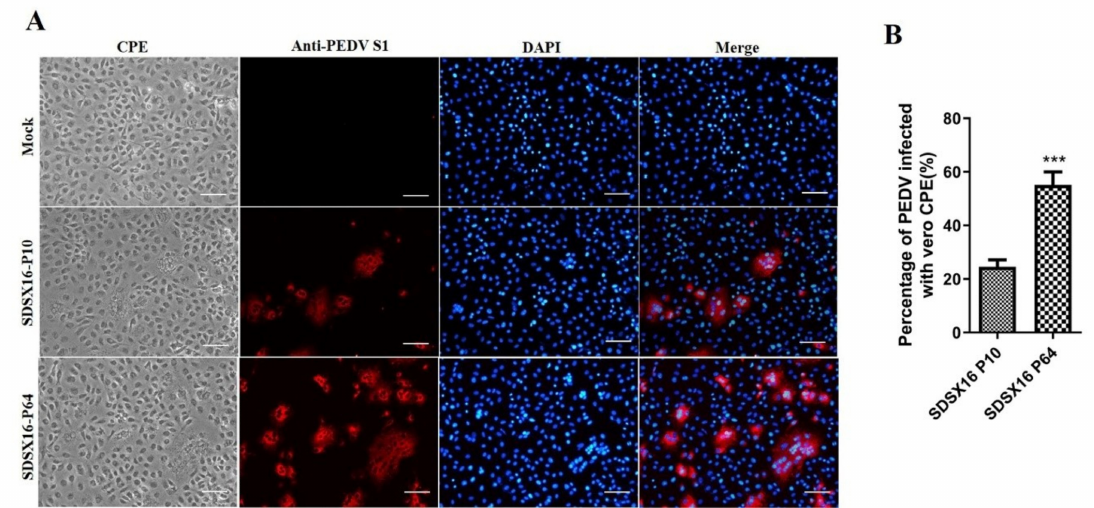
Figure 1. Cytopathology and immunofluorescence assay (IFA) of PEDV isolate SDSX16 in Vero cells. ( A ) Vero cells were infected with PEDV SDSX16-P10 and SDSX16-P64 isolates. PEDV-specific CPEs were monitored daily and were photographed at 48 h post-infection (hpi) using an inverted microscope (first column). For immunostaining, infected cells were fixed at 48 hpi and incubated with MAb against the S protein, followed by FITC conjugated donkey anti-mouse IgG antibody (second column). The nuclei were counterstained with DAPI (third column) and examined using a fluorescence microscope. Scale bar represents 20 µ m. ( B ) Statistical results of the percentage of total cell number of cells producing CPE infected by PEDV in the visual field. Data are shown as mean ± SEM (*** p < 0.001). The titer of the SDSX16 was measured every ten generations. The virus titers ranged from 10 4.15 to 10 4.50 TCID 50 / mL up to SDSX16-P5, and the peak viral titer reached 10 7.6 TCID 50 / mL after passage 100. The titer of SDSX16-P70 (7.44 log 10 TCID 50 / mL) was approximately 10-fold higher than that of